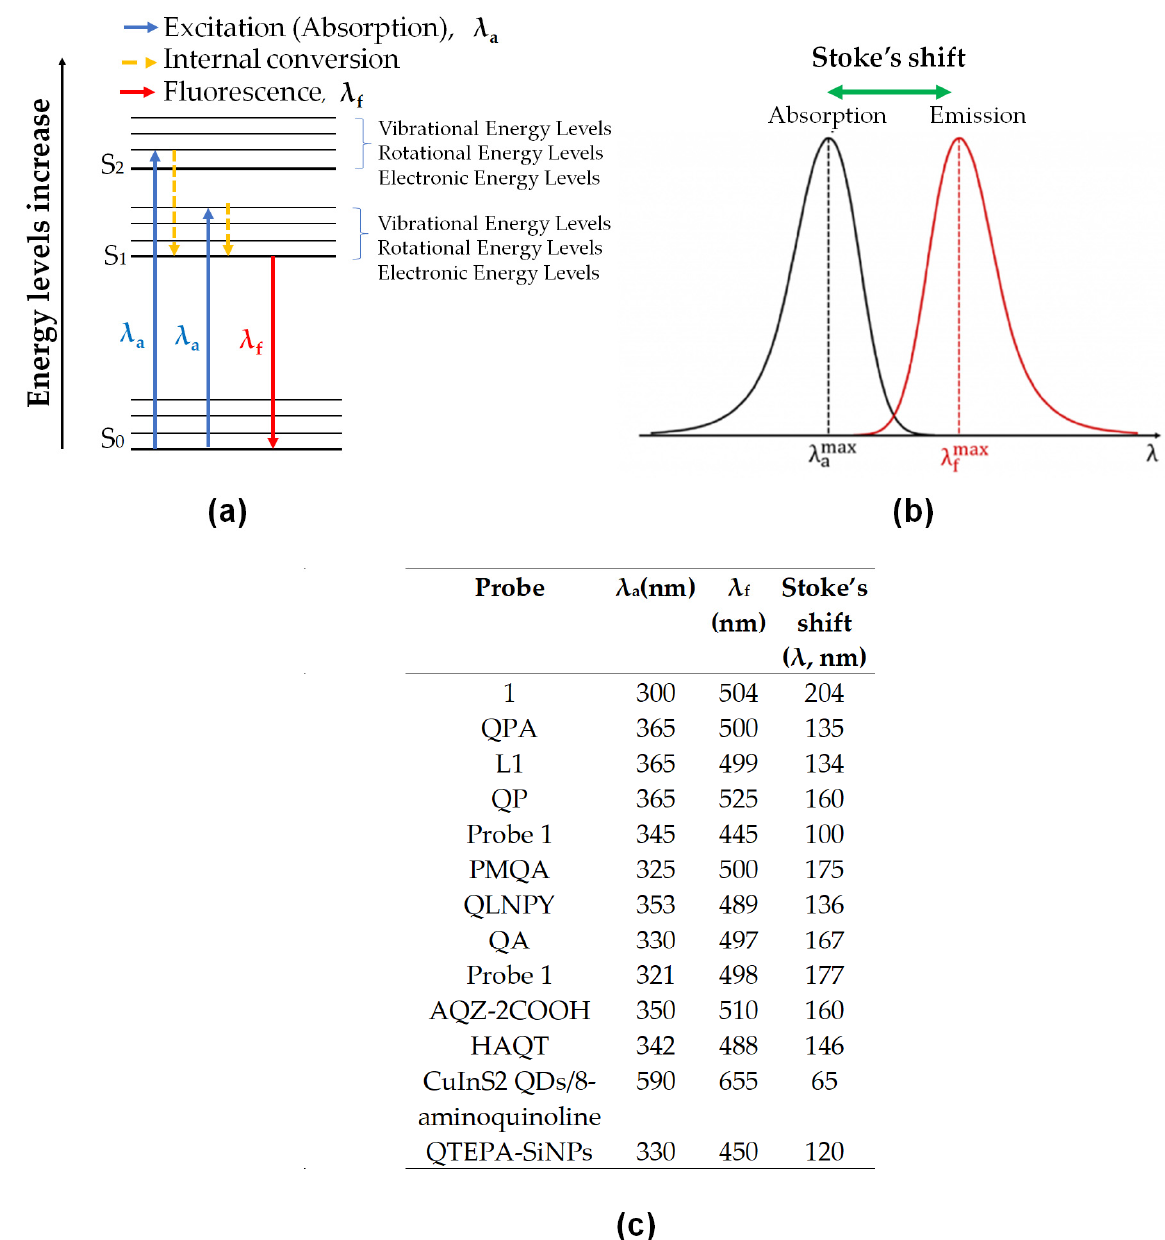
Figure 10. ( a ) Simplified Jablonski diagram energy level; where the blue arrow is excitation wavelength maximum and the red arrow is emission wavelength maximum. ( b ) The diagram on how to identify Stoke’s Shift, in wavelength (nm). ( c ) Table of details absorbance, emission and stoke’s Shift for all probe in Table 2; Stoke’s Shift calculated from the difference between emission and absorbance wavelength.